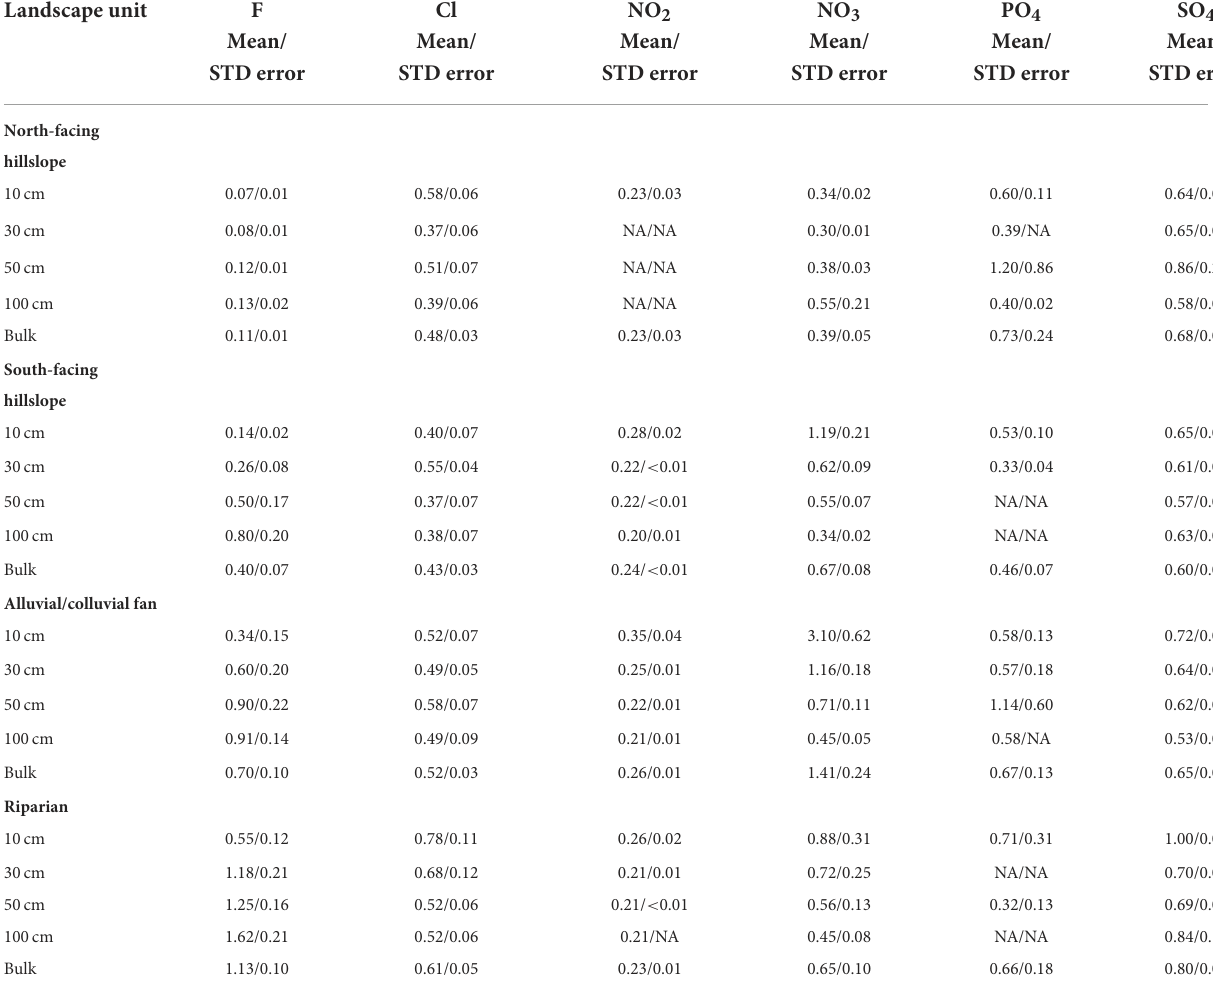
TABLE 3 Mean and standard error for each of the studied anion concentrations at each depth, and bulk, for every landscape unit. Landscape